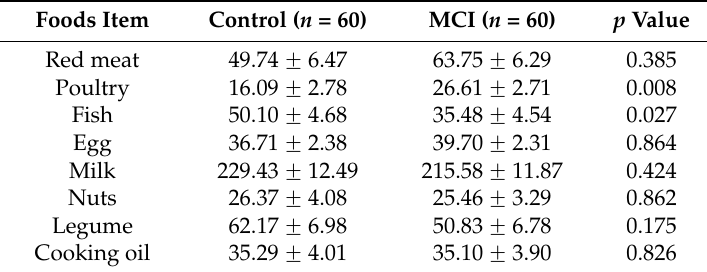
Table 2. Intake of lipid-rich foods of MCI patients and control subjects